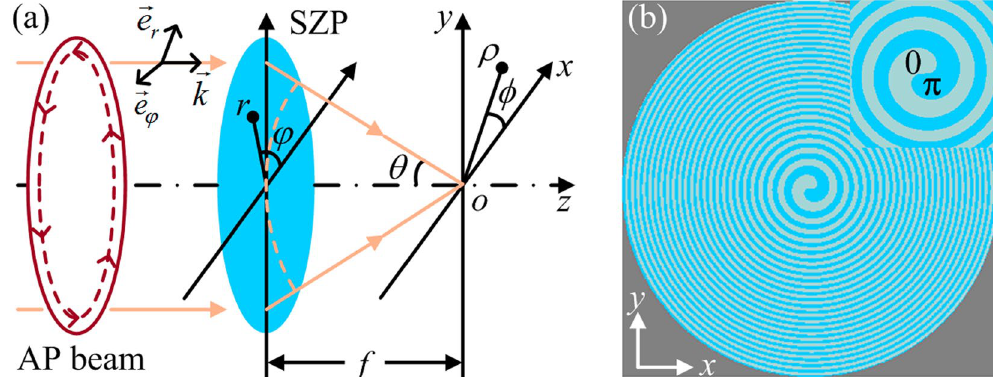
Figure 1. Schematic of forming a subwavelength spot and a three-dimensional optical trap by a single planar element with AP light. ( a ) System layout, and ( b ) phase structure of the SZP with p = 1 and N max = 24. Inset is the enlarged image of the SZP centre